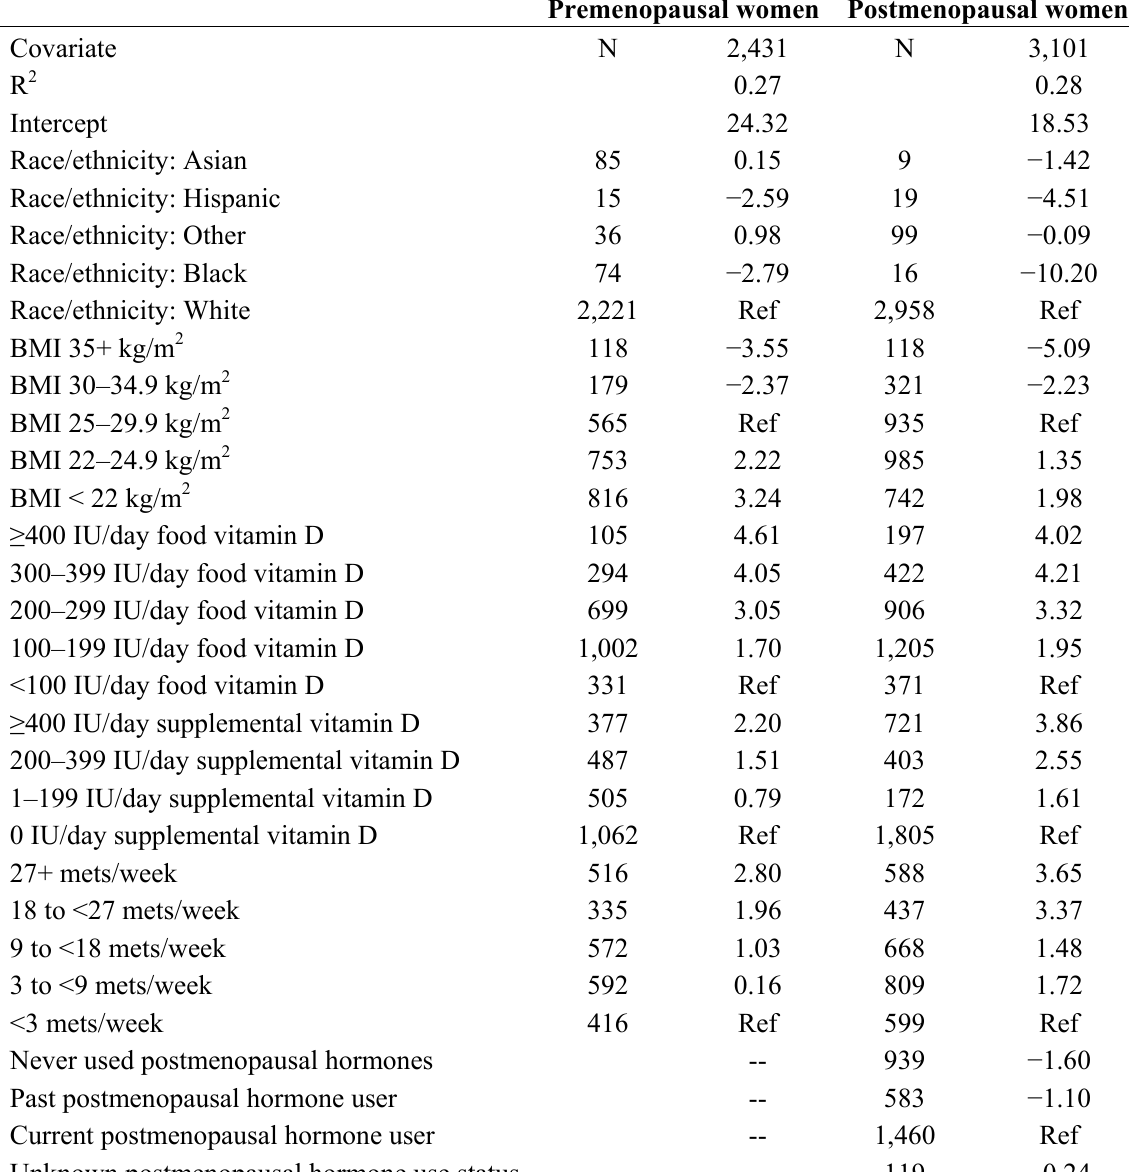
Table A1. Loading factors of predictors of plasma 25(OH)D levels from multiple linear regression models for premenopausal and postmenopausal women from NHS and